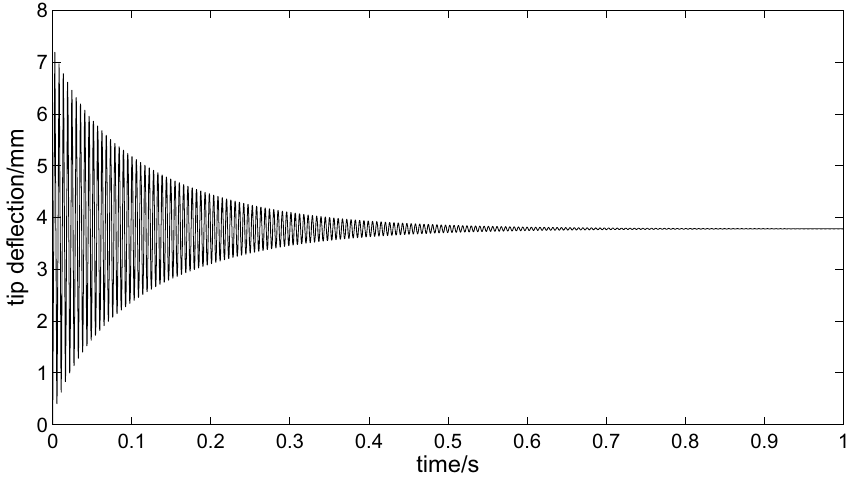
Fig. 5. Decaying oscillation of the tip’s free end; differences between the different concepts are not visible